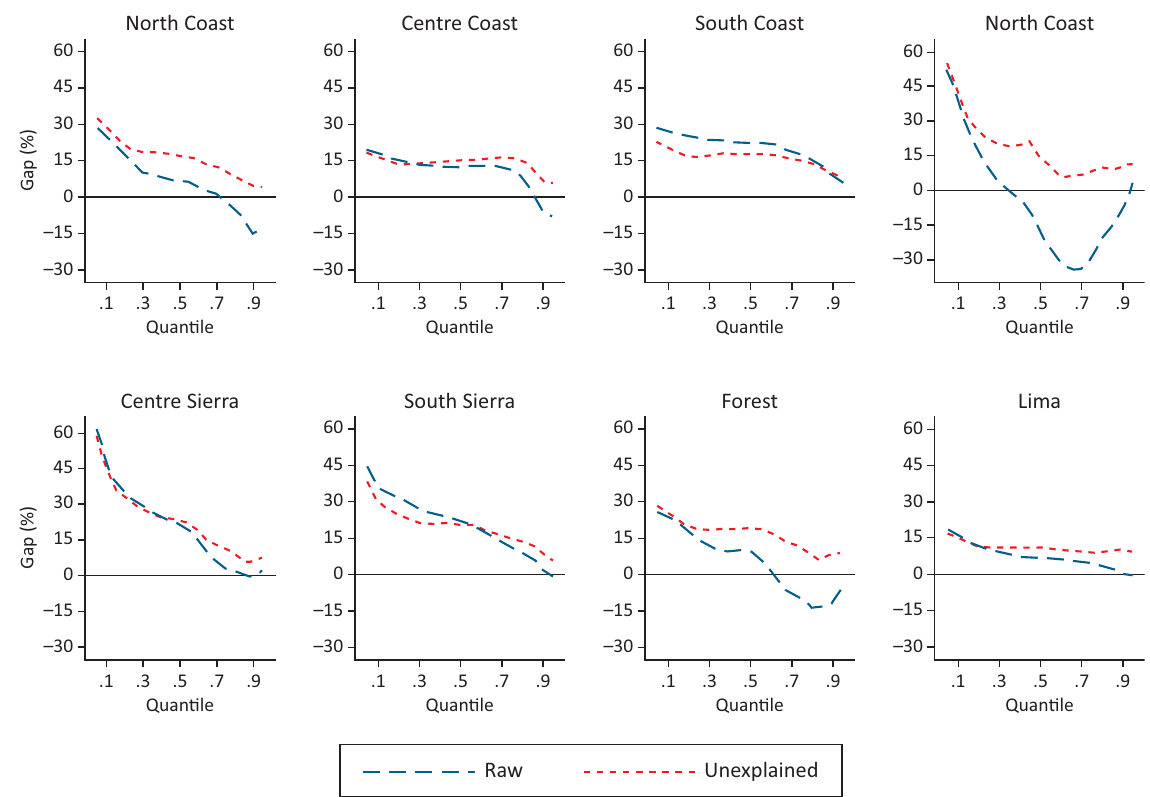
Figure 5. Regional Machado‐Mata quantile decomposition. Notes: All decompositions include controls such as education, native tongue, age, tenure, private sector and firm size, occupation, economic activity, and regional fixed effects; the param‐ eter in the MM is set to